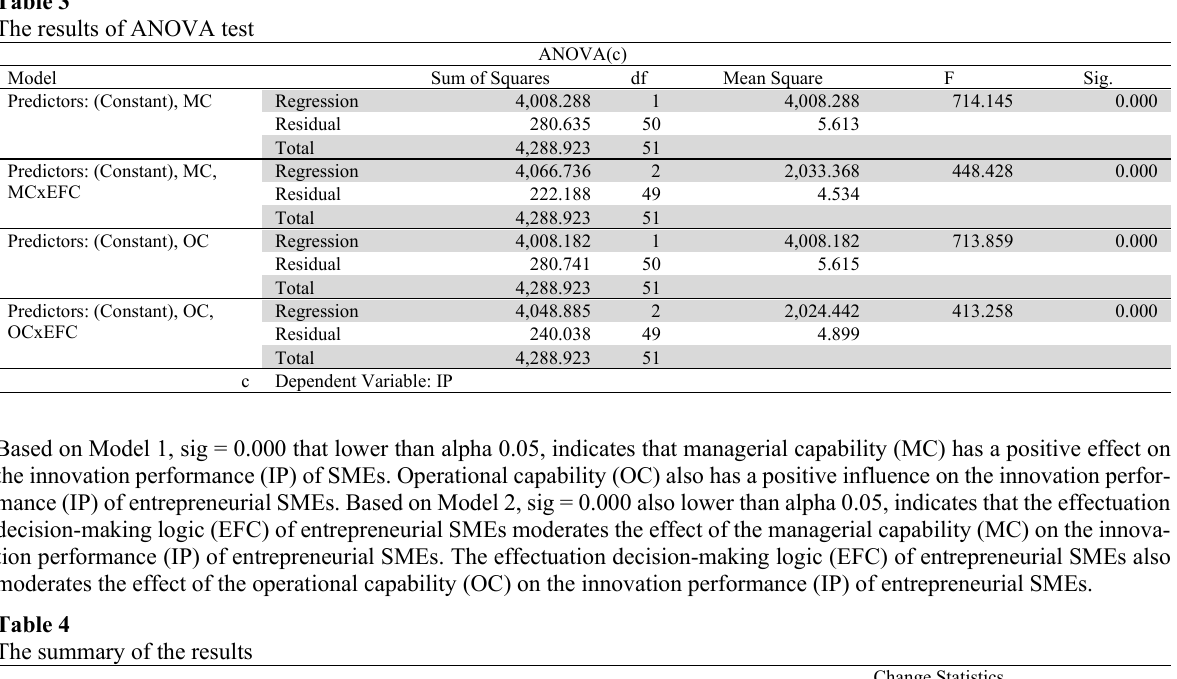
The summary of the results